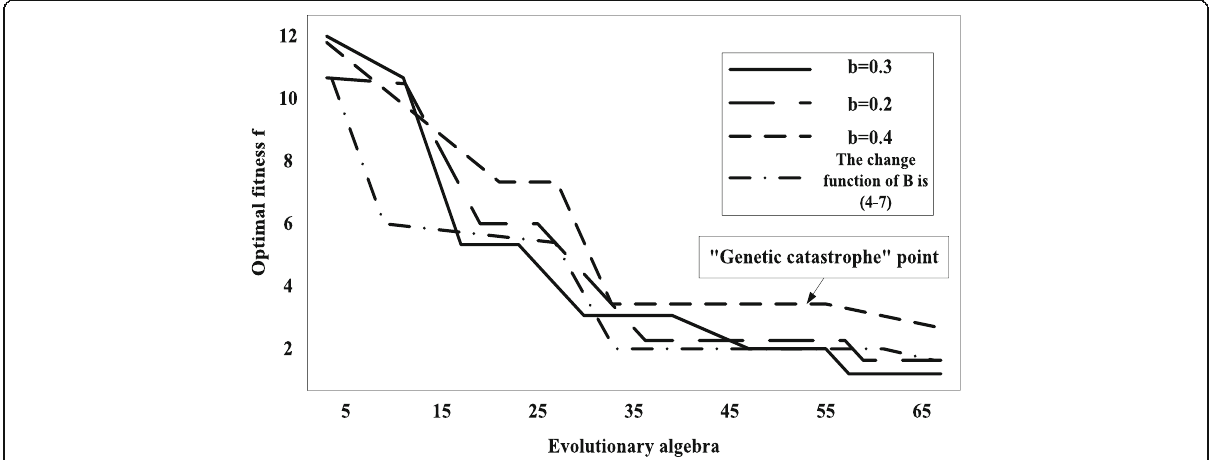
Fig. 6 Diagram of the relationship between evolutionary algebra and optimal fitness